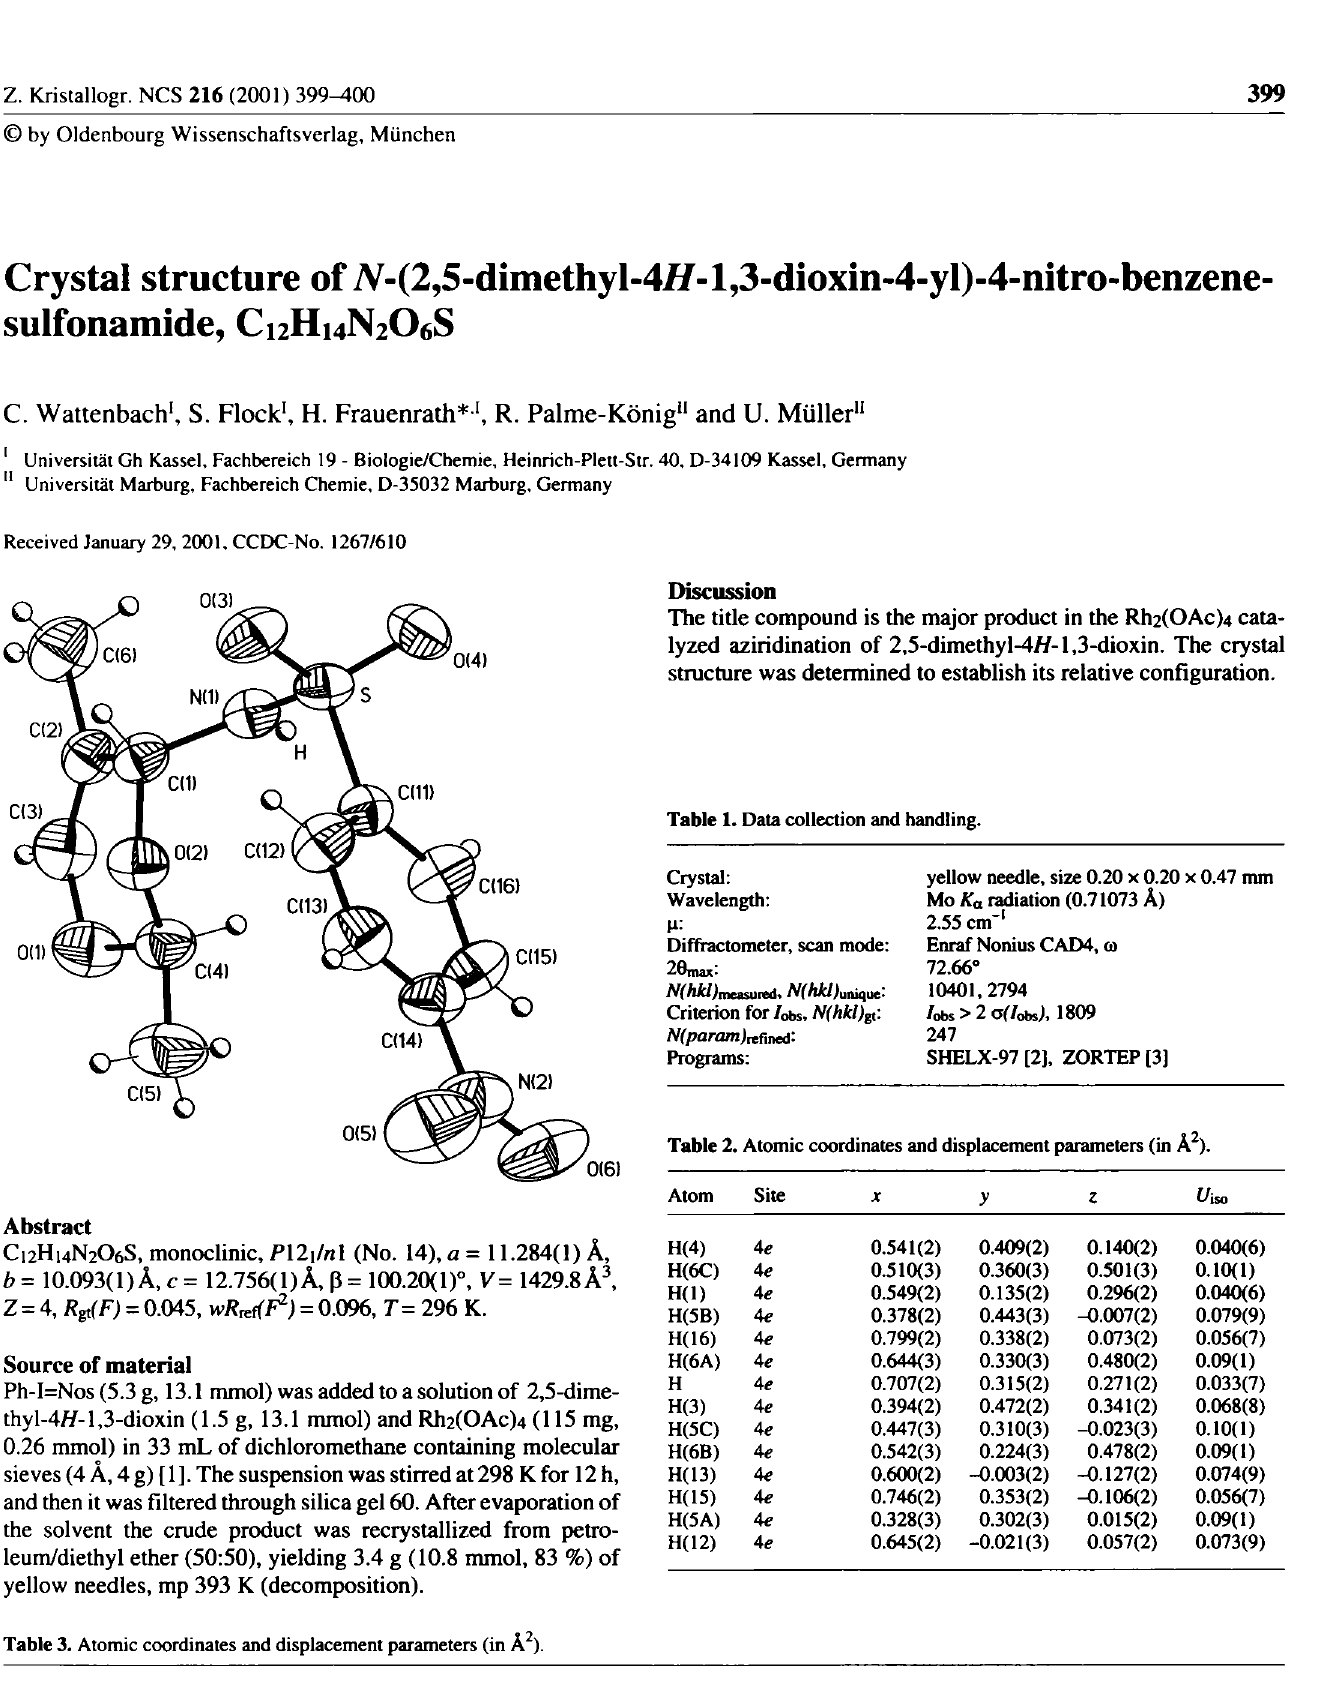
Table 3. Atomic coordinates and displacement parameters (in Ä 2 ).